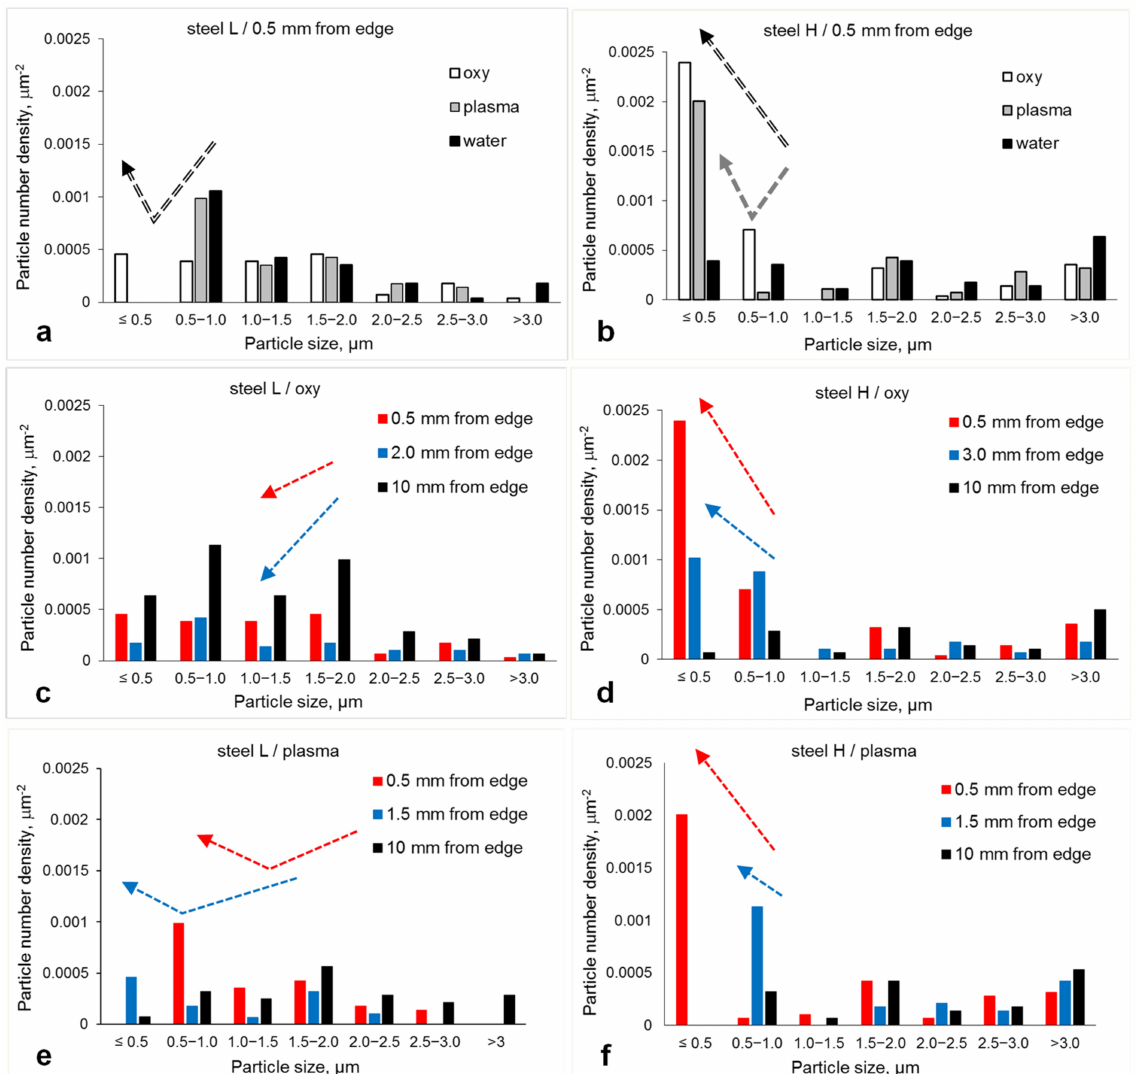
Figure 7. Coarse (TiMoV)(CN) particle number density distributions at 0.5 mm position from the cut edge in Steels ( a ) L and ( b ) H, for the samples cut with oxy-fuel in Steels ( c ) L and ( d ) H, and for the samples cut with plasma in Steels ( e ) L and ( f ) H; arrows in ( a , b ) indicate the directions of distributions peaks shift for oxy-fuel and plasma cutting methods with respect to the distribution observed for the water jet cutting, and these in ( c – f ) indicate the directions of distributions peaks shift for 0.5/2.0/3.0/1.5 mm positions with respect to the distribution for the 10 mm